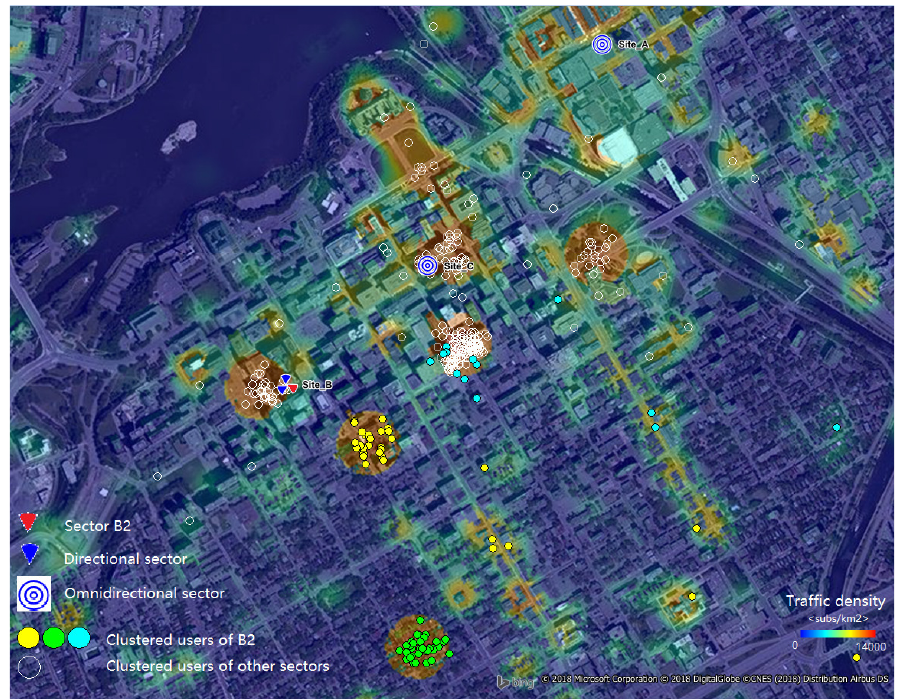
Figure 10. Working hour user distribution and clustering for Sector B2 and ∆ θ = 30 ◦